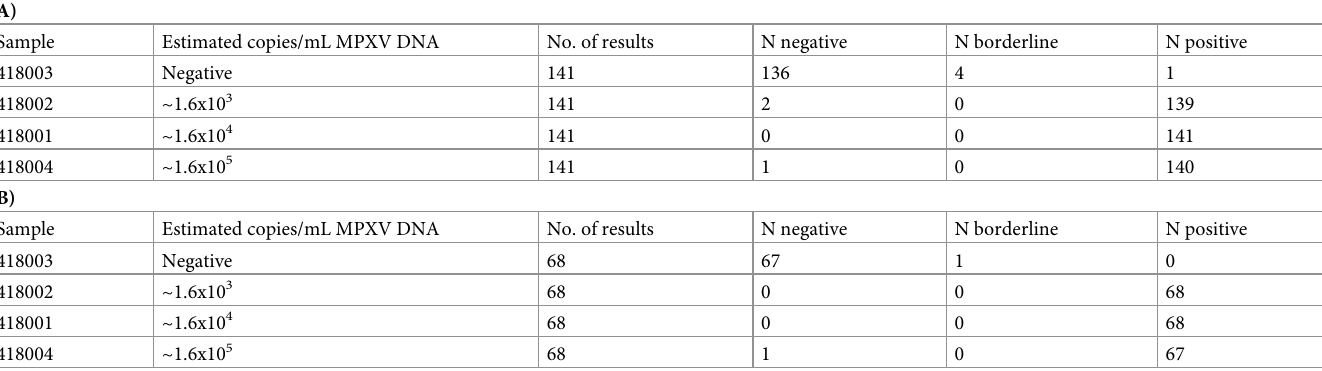
Table 3. Qualitative PCR results for the four samples of monkeypox EQA survey for A) MPXV DNA and B) OPXV DNA.